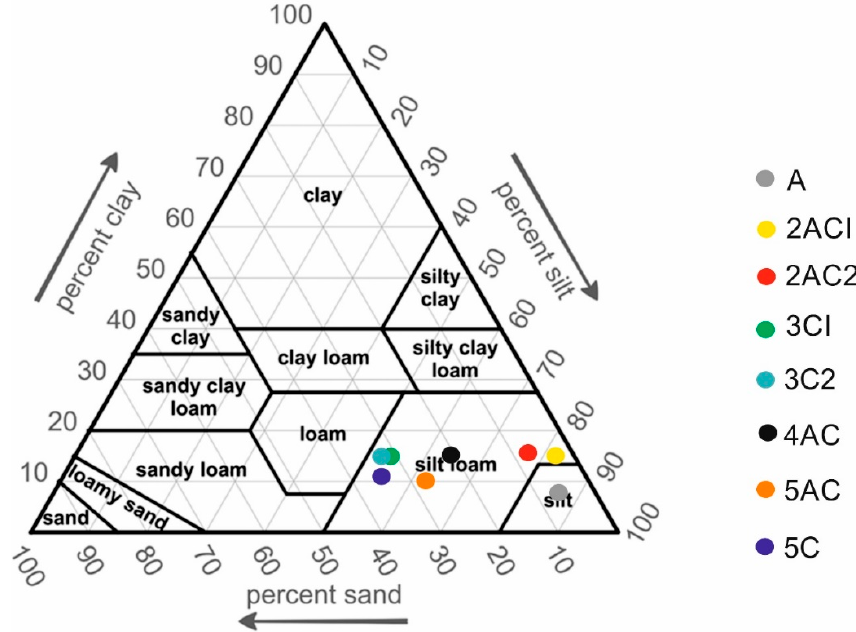
Figure 2. Soil texture of analyzed soils.